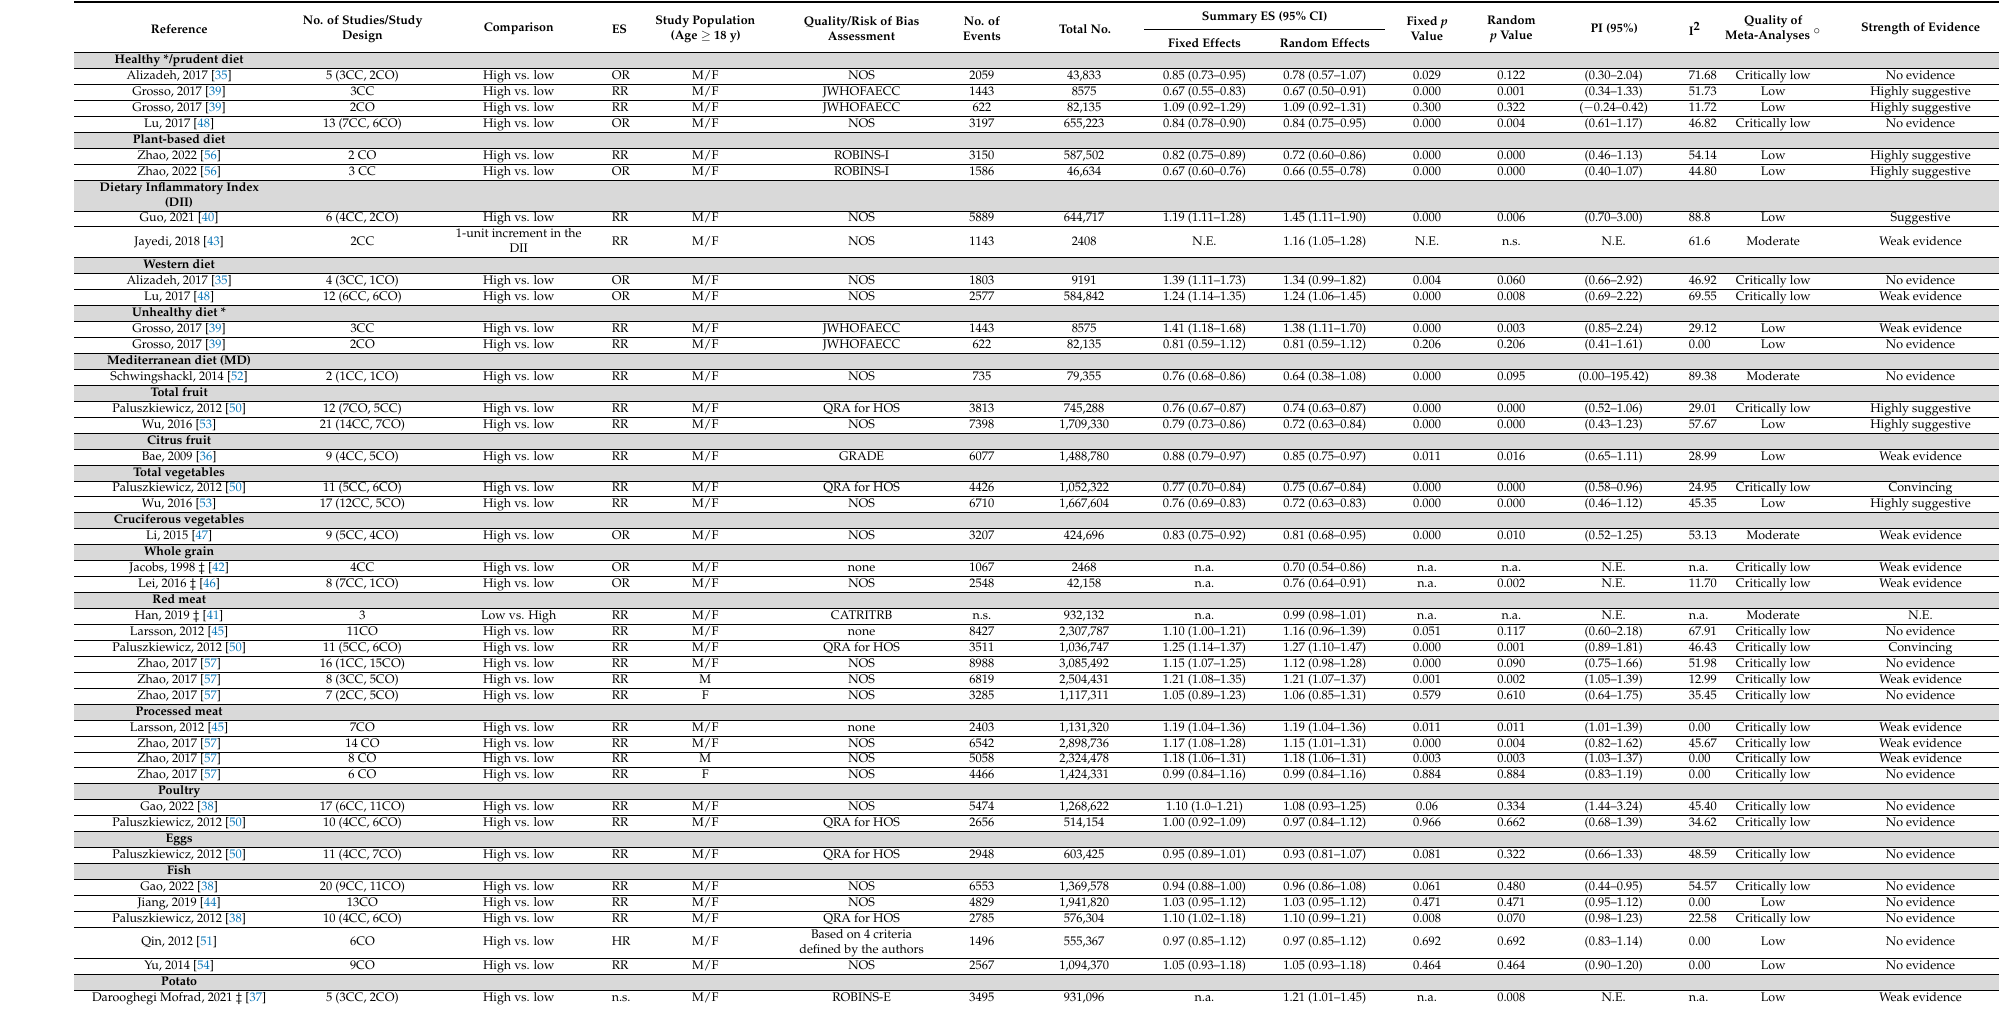
Table 2. Main characteristics and quantitative synthesis of meta-analyses reporting association between dietary patterns, stratified by dietary patterns and single food components, reported in alphabetical order (of the first